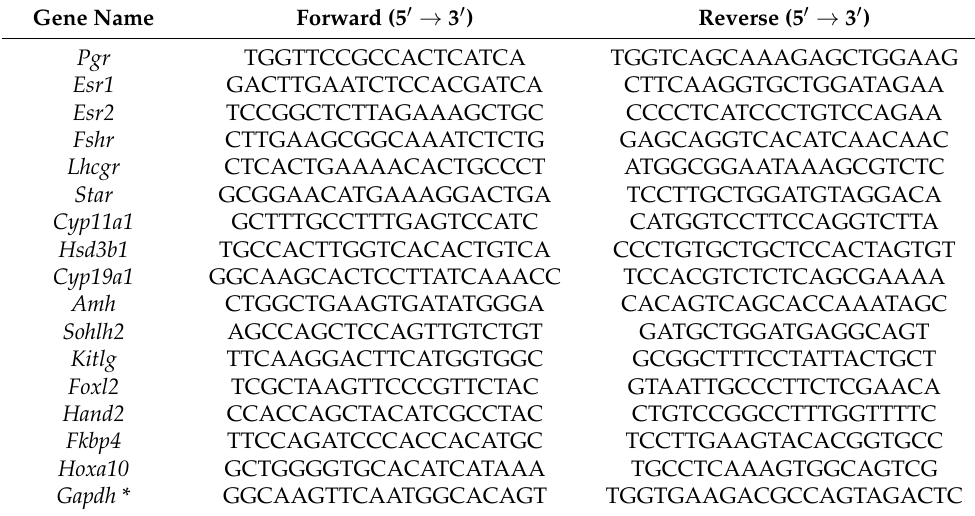
Table 1. qPCR primer